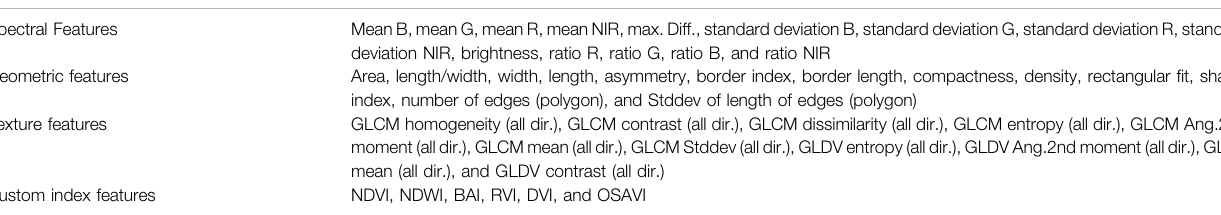
TABLE 1 | Object initial feature space for QuickBird image, WorldView-2 image, and Gaofen-2 image.